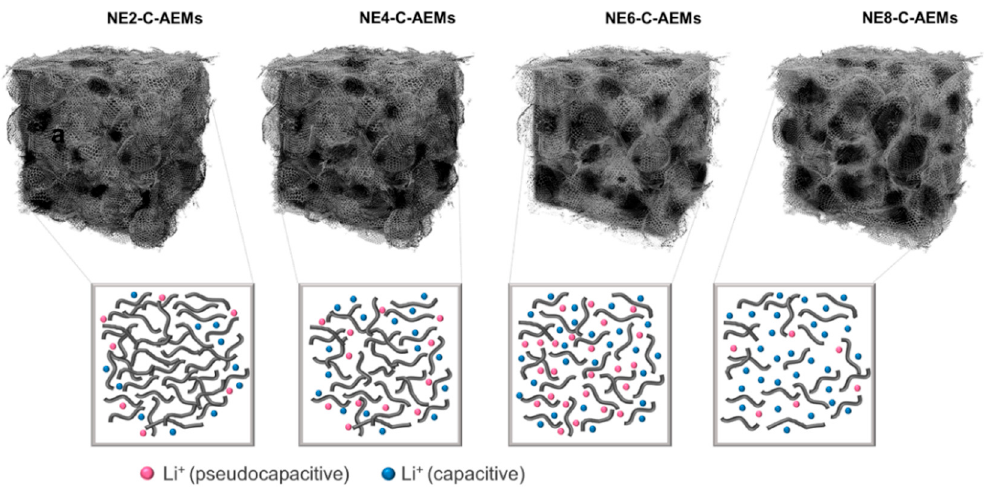
Figure 5. Schematic image showing the relationship between the pore size and charge storage performances on the nanoporous carbon.